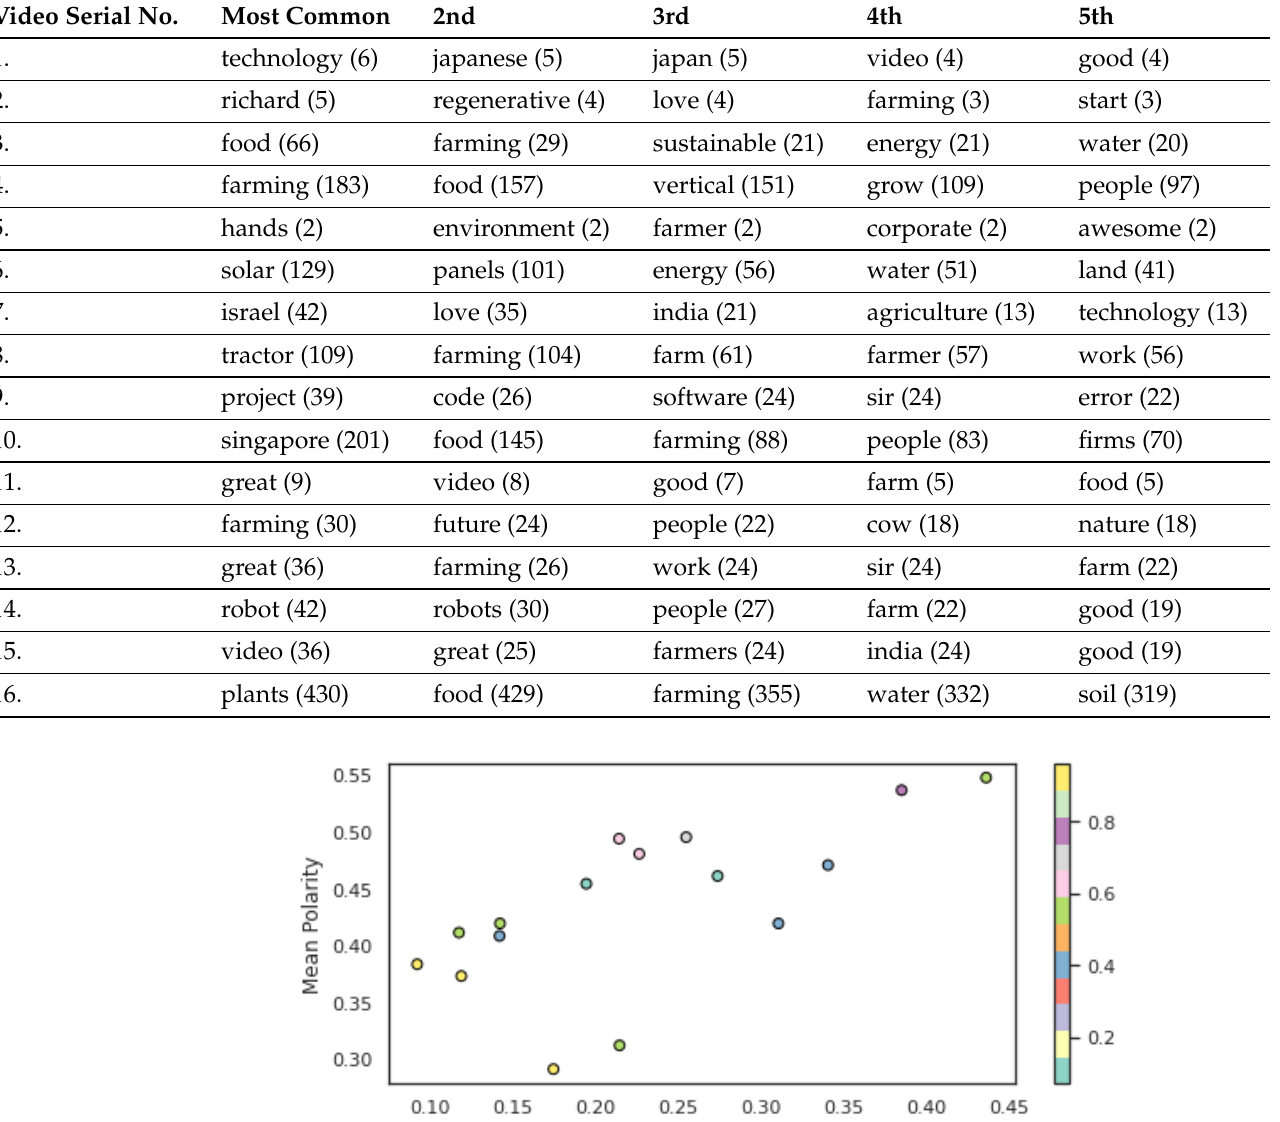
Table 11. List of five most frequent words for each video with respective frequencies.